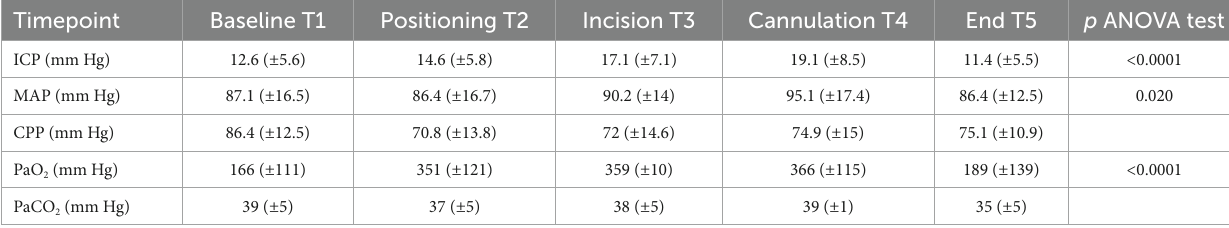
TABLE 3 Variation of main parameters recorded at five predetermined time points during the tracheostomy